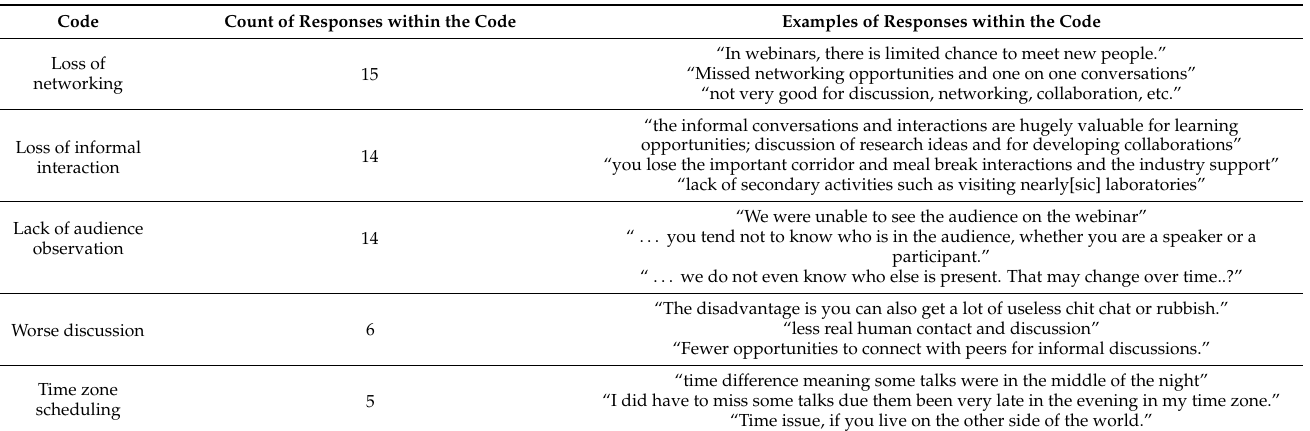
Table 2. Downsides to online